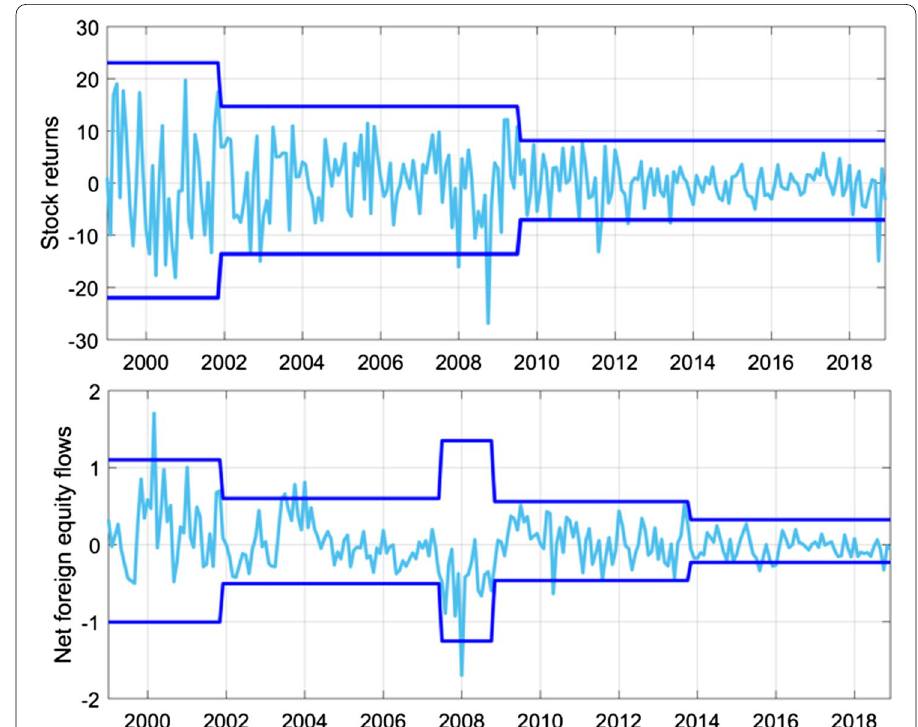
Fig. 2 Structural breaks in the variance of stock returns and net equity flows